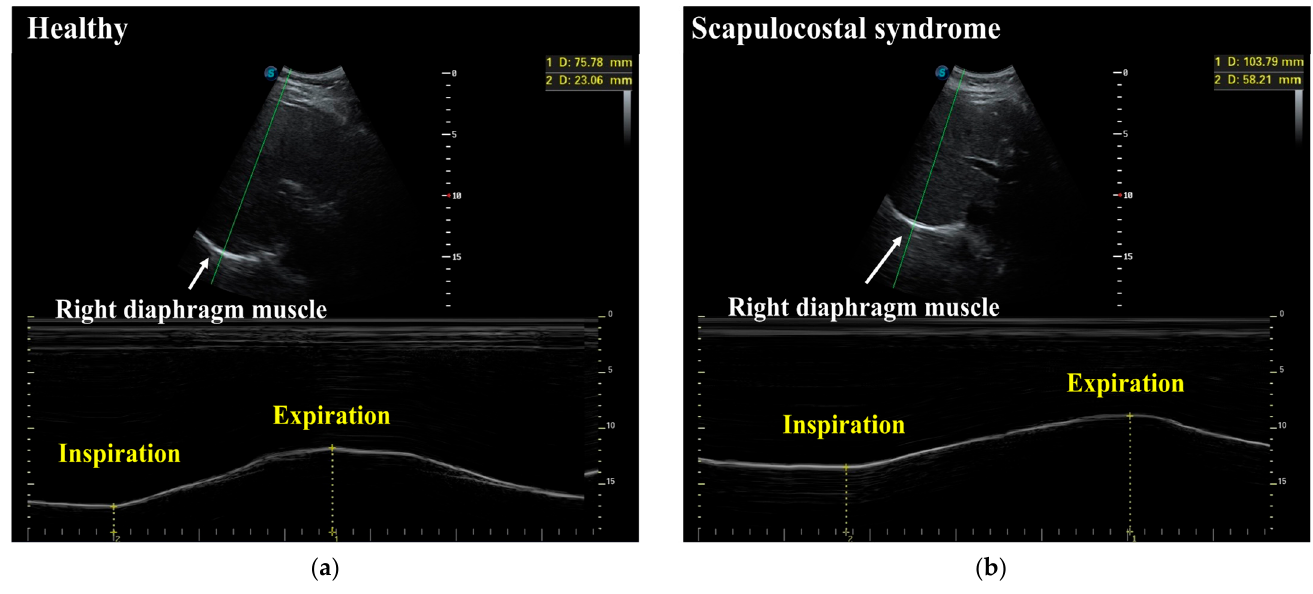
Figure 1. Example of comparison of diaphragmatic mobility using real-time ultrasound in ( a ) a healthy participant, and ( b ) a scapulocostal syndrome patient.